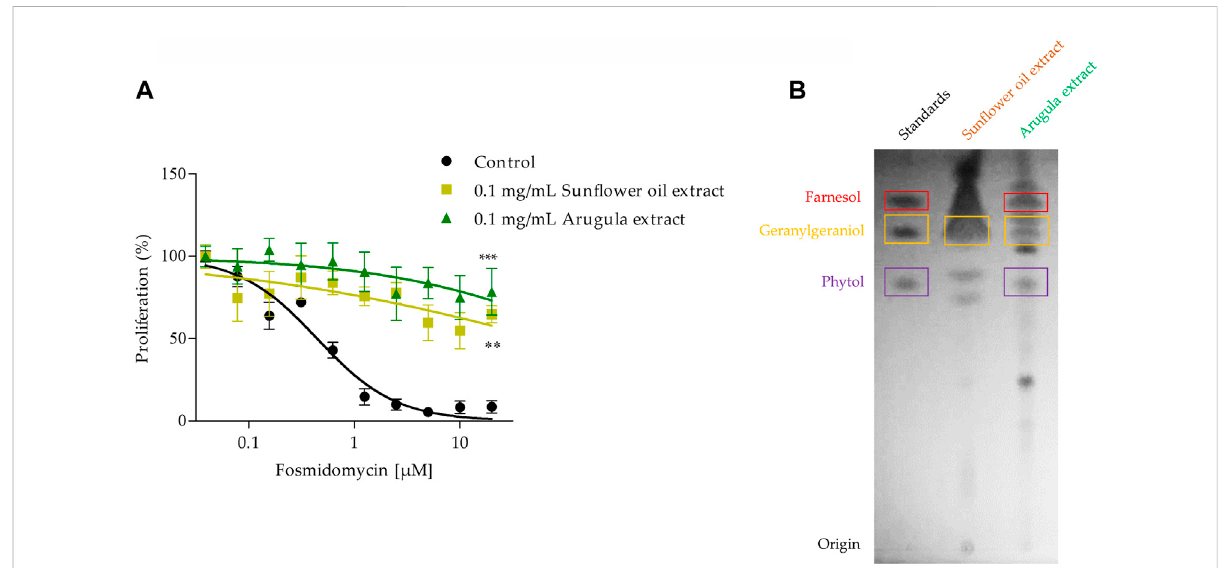
FIGURE 8 Fosmidomycin-rescue assays using sun fl ower oil and arugula extracts. (A) It was studied the fosmidomycin (initial concentration 20 µM) dose- response effect at 48 h in the presence or absence of 0.1 mg/ml sun fl ower oil and arugula extracts. Fosmidomycin IC 50 = 0.7µM ± 0.3. These experiments were carried out using the SYBR Green I ® DNA staining methodology. Values represent the mean ± SD from three independent assays. Statisticalanalysis wasperformed withOneWayANOVA, followedbytheTukeyposttest(*** p < 0.005comparedto thecontrol). In (B) theTLC chromatographic analysis of the different extracts is shown as well as the FOH, GGOH and POH